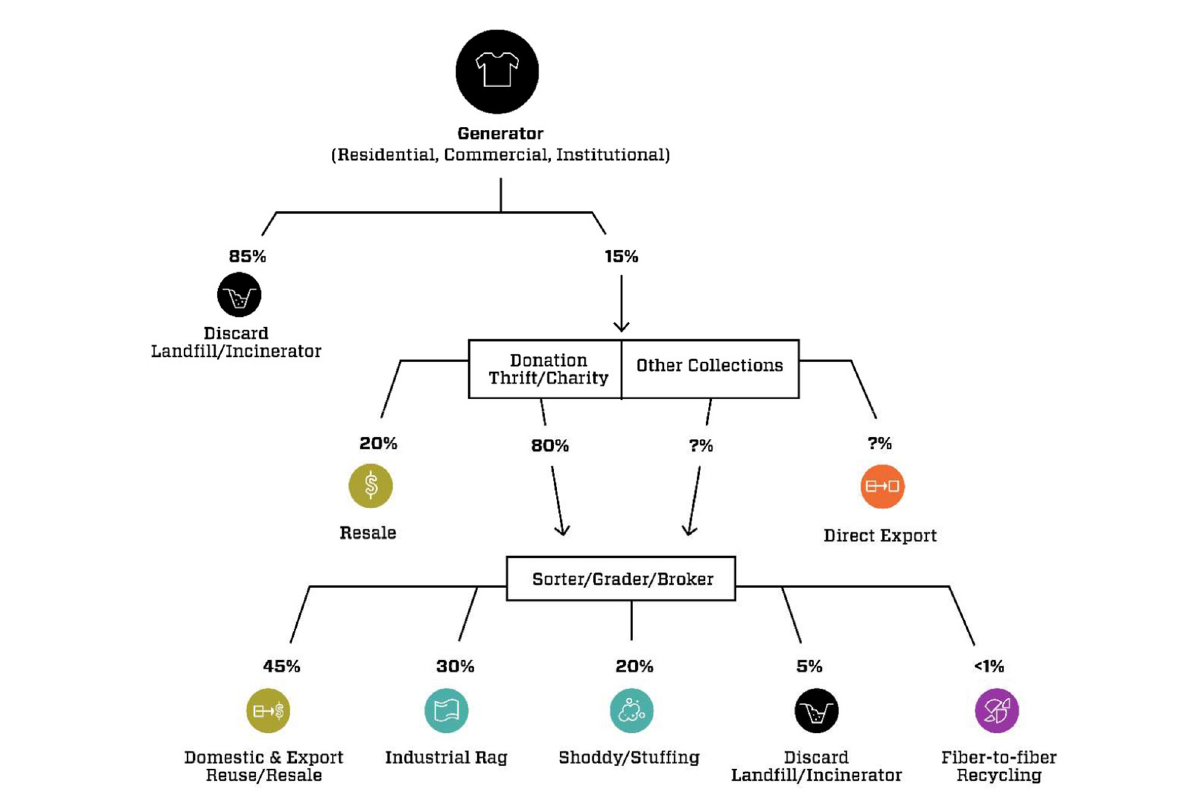
FIGURE4 Current fate of used textiles in the United States. Question marks indicate flows for which reliable data are unavailable. Shoddy is made from shredded fibers and used for insulation and stuffing. Based on data from Adler (2021), US EPA (2021b), Magruder